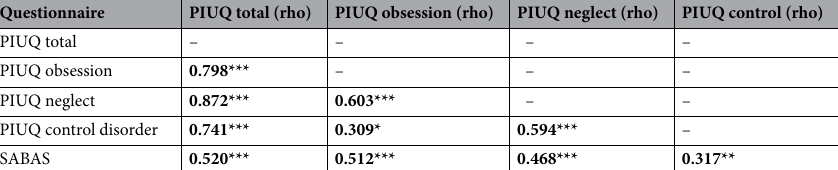
Functional connectivity analysis results.